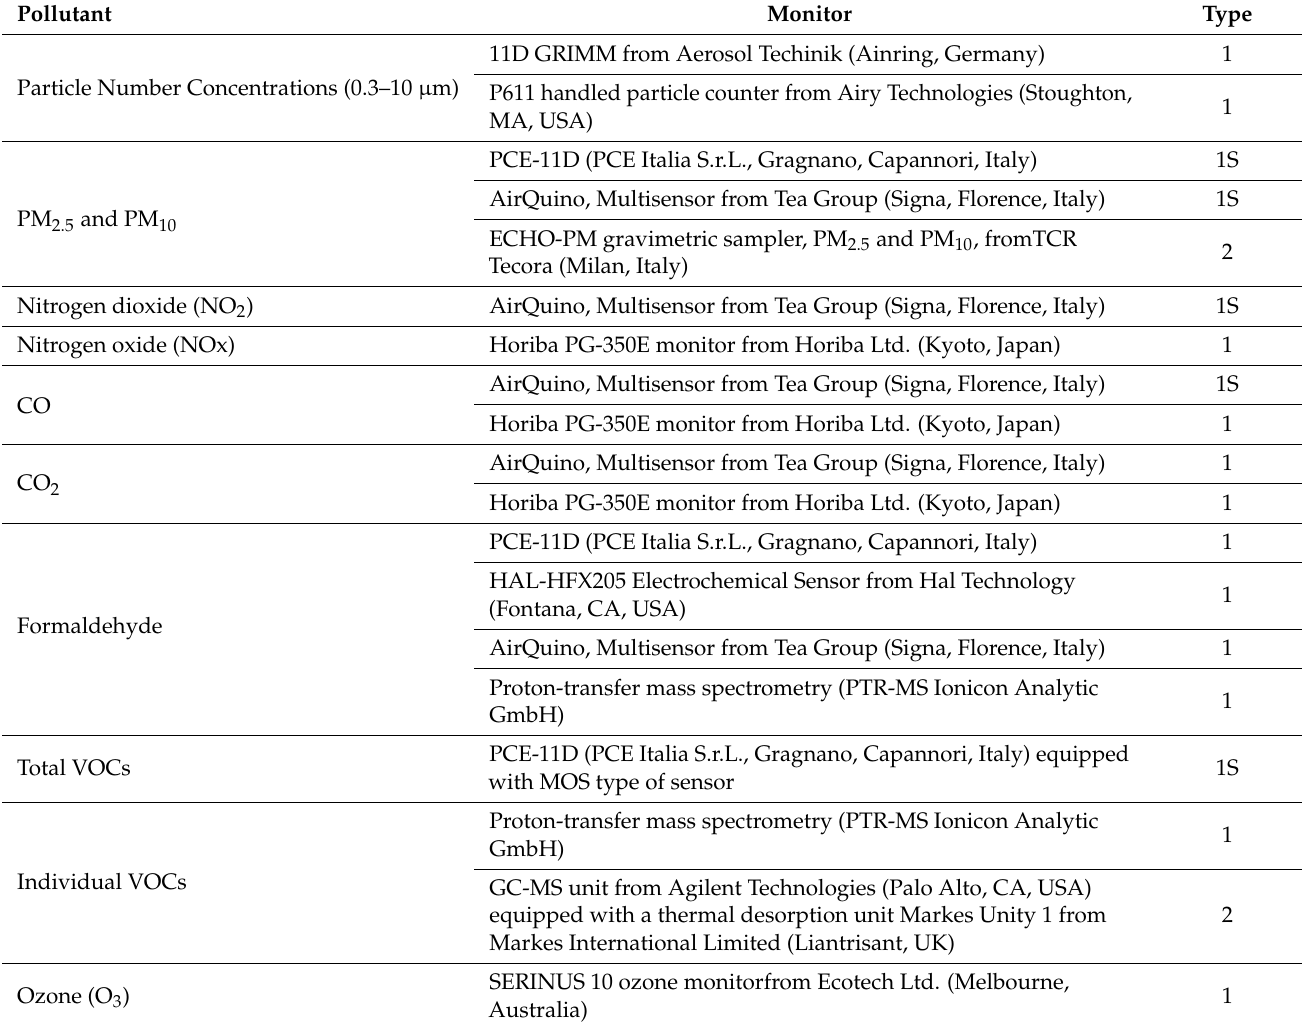
Table 1 lists the type of instruments used to monitor the concentrations of different pollutants in the testing room. Table 1. List of the monitors used to measure the concentrations of pollutants in the testing room. 1 = on-line monitors; 2 = out-of-line monitors; and S = solid state MOS type of